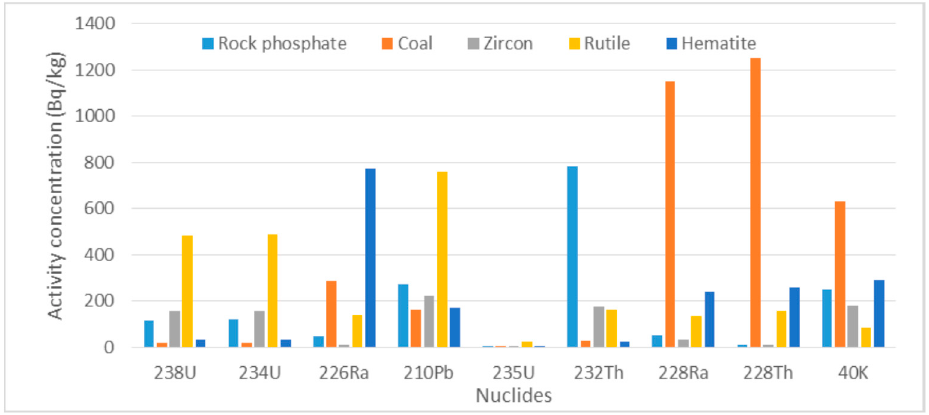
Figure 3. Concentrations of nuclides in various minerals within the Transnet facility in Richards Bay.